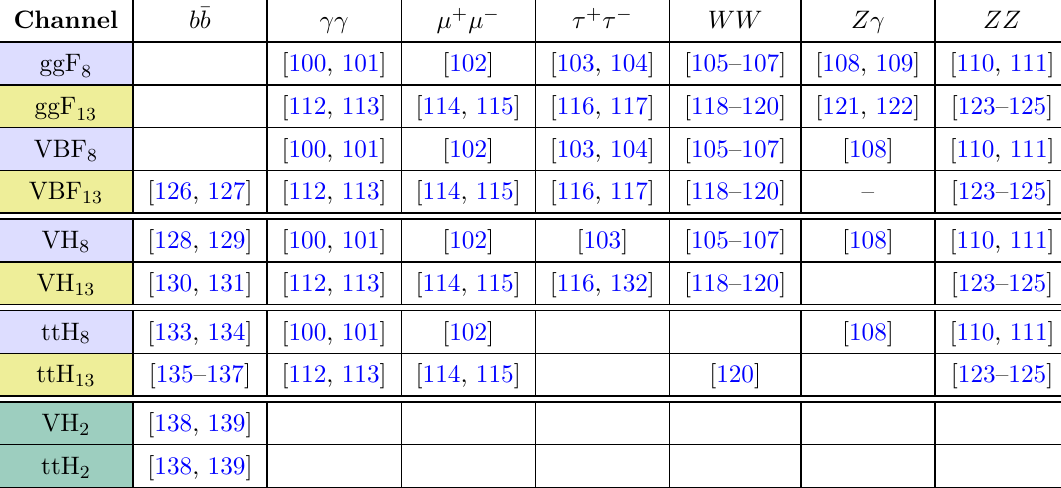
√ s = 13 TeV (ATLAS and CMS, Run II)